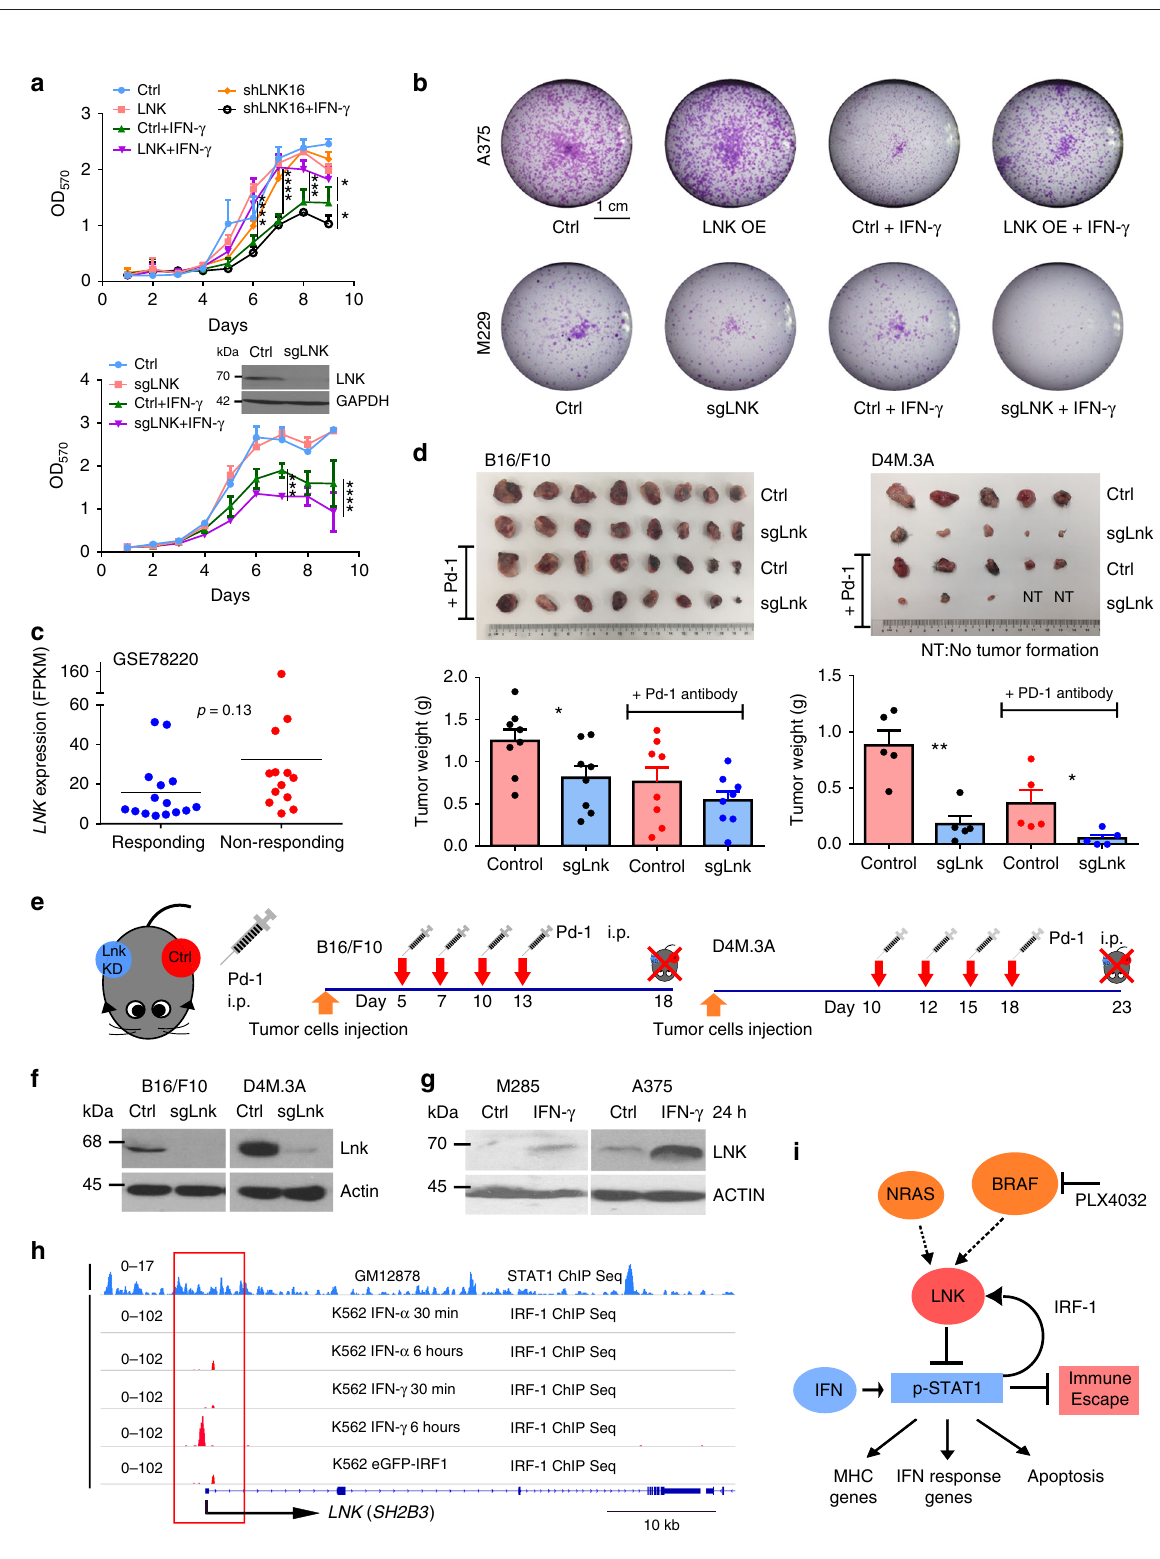
Fig. 5 Silencing of LNK enhances IFN signaling in melanoma cells. a GSEA analysis of signi fi cantly enriched gene expression signatures in A375 melanoma cells with silenced LNK using different CRISPR-Cas9 guide RNA. Cells were either cultured with or without IFN gamma (400 U/ml, 24 h); and gene expression was analyzed using RNA sequencing. NES, normalized enrichment score; FDR, false discovery rate. The color scale indicates the positive (red) or negative (blue) correlation. b Silencing of LNK enhanced the IFN- γ induced (400 U/ml, 24 h) gene expression of MHC class I and II. c Silencing of LNK enhanced the IFN response gene expression in A375 cells. d Real time PCR analysis of IFN induced genes expression in A375 cells with either forced expression (LNK OE) or silencing of LNK (sgLNK), either with or without IFN- γ treatment (2000 U/ml, 24 h). * P < 0.05; ** P < 0.01; *** P < 0.001; **** P < 0.0001; ns, not signi fi cant; unpaired two tailed t -test. Error bars represent